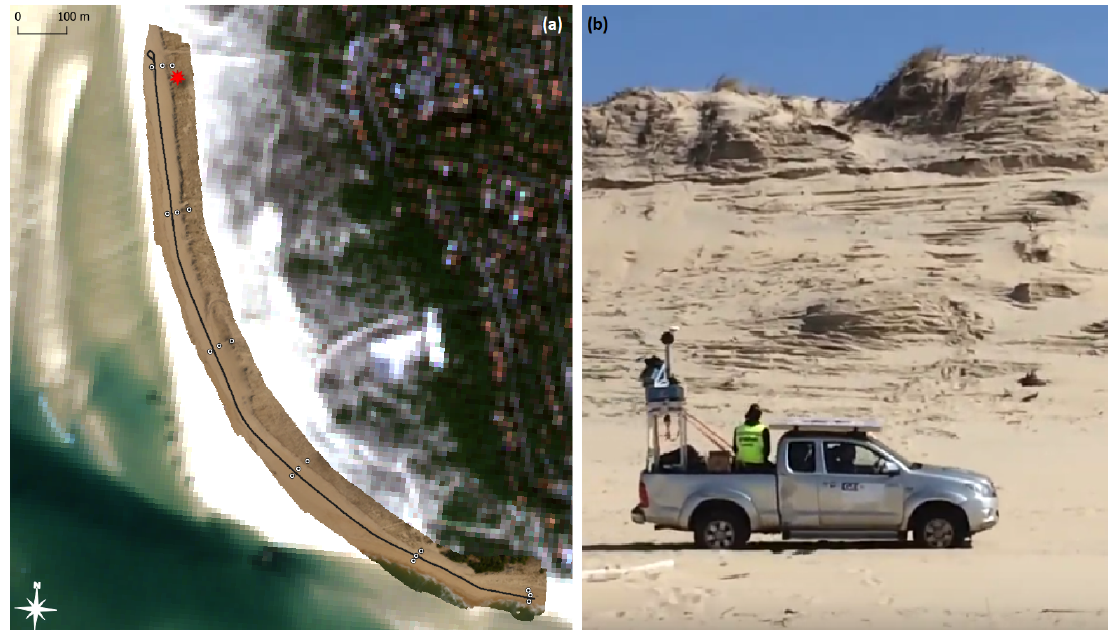
Figure 3. On site survey. ( a ) UAS orthophoto on top of Sentinel satellite imagery, with the GNSS base station (red star), the ground control points (black/white circles) and the car trajectory (black line). ( b ) The MLS heading southward with the dune cliff in the